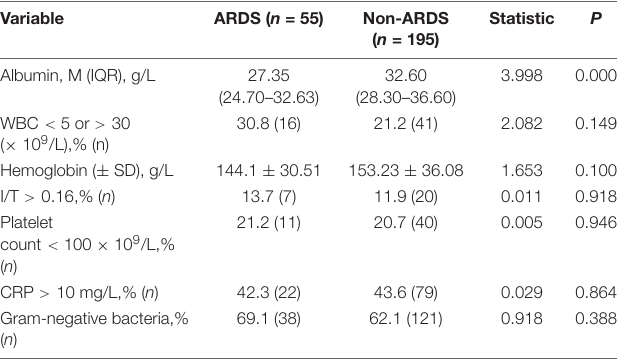
TABLE 2 | Comparison of laboratory results between the two groups of infants.